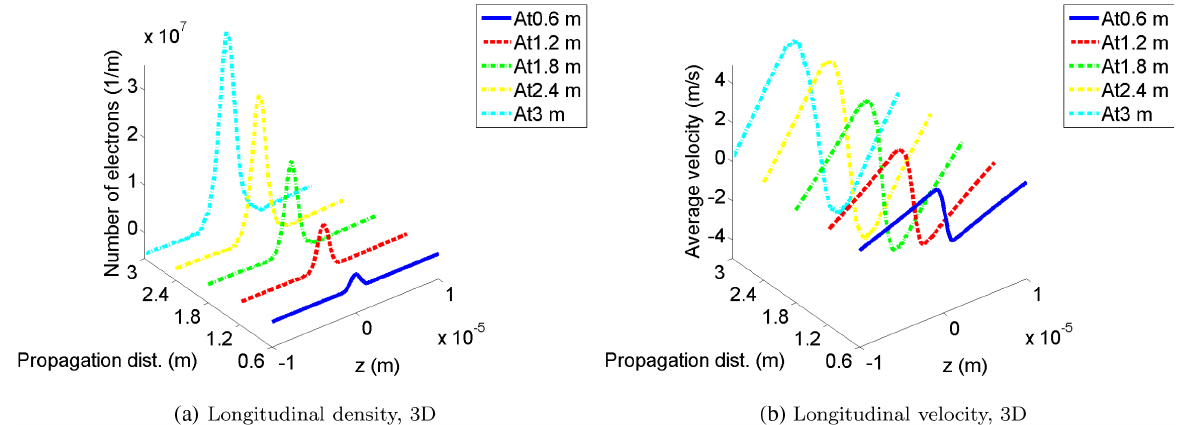
FIG. 12. Longitudinal density and velocity modulation by stationary ion on axis of the Gaussian electron beam in the CeC modulator: blue, solid line — after 0.6 m, red, dash line — after 1.2 m, green, dash-dot line — after 1.8 m, yellow, dash-dot line — after 2.4 m, and cyan, dash-dot line — after 3 m of copropagation through the modulator.